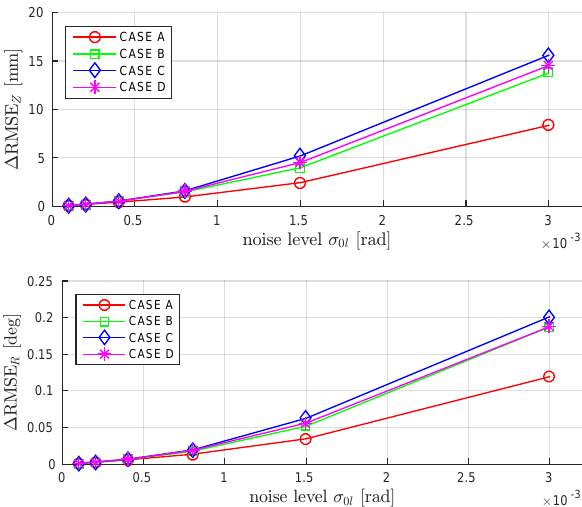
Figure 7. Deviations between the RMSE of estimated camera positions and rotations of ideal result and approximations C ASE A-D at different noise levels σ 0 l of dataset F IELD . Figure 8 gives the loss in accuracy L C in percent, which can ASE be obtained with Eq. (36), under different noise level σ 0 l for each